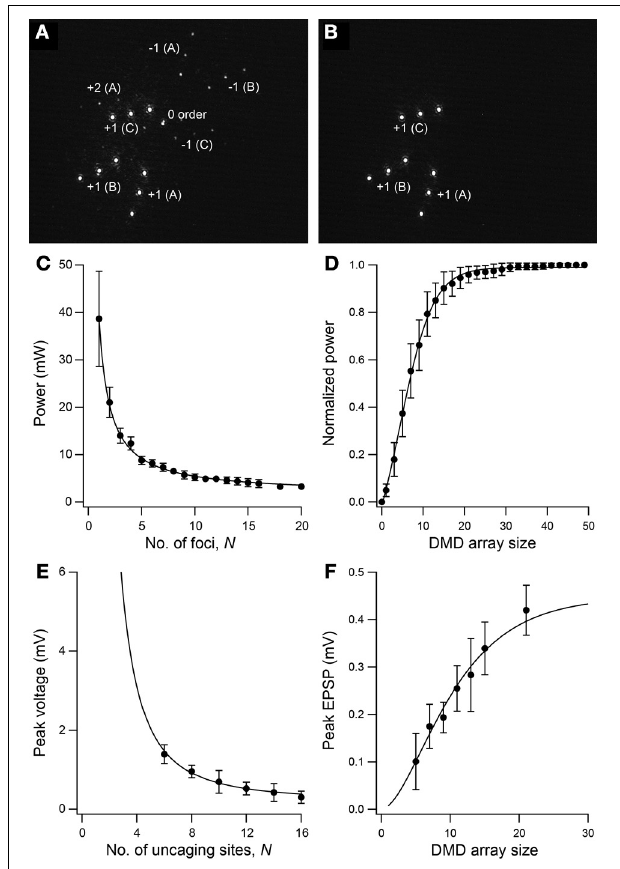
FIGURE 2 | SLM-generated 3D photostimulation pattern with DMD gating. (A) Nine-foci light pattern produced by the SLM with all DMD pixels turned ON showing zero order (0 order), second order [ + 2 (A)] and mirror projections [ − 1 (A–C)] of the first diffraction order [ + 1 (A–C)]. (B) Same photostimulation pattern as in (A) but with only the nine desired foci gated by the DMD. All other light is eliminated by being directed to the beam dump. (C) Power on one ON focus as a function of number of foci, N ( n = 10 different spot configurations). For N = 2–20, the ON focus was kept at a fixed position. Solid line is 1/ N fit. (D) Normalized power as a function of DMD array size ( n = 10 focal spot positions). Solid line is a cumulative Gaussian fit. (E,F) Peak of glutamate-evoked voltage from one ON uncaging site as a function of (E) number of uncaging sites and (F) DMD array size ( n = 8–10 trials). Solid lines are proportional to squares of curve fits in C and D ,